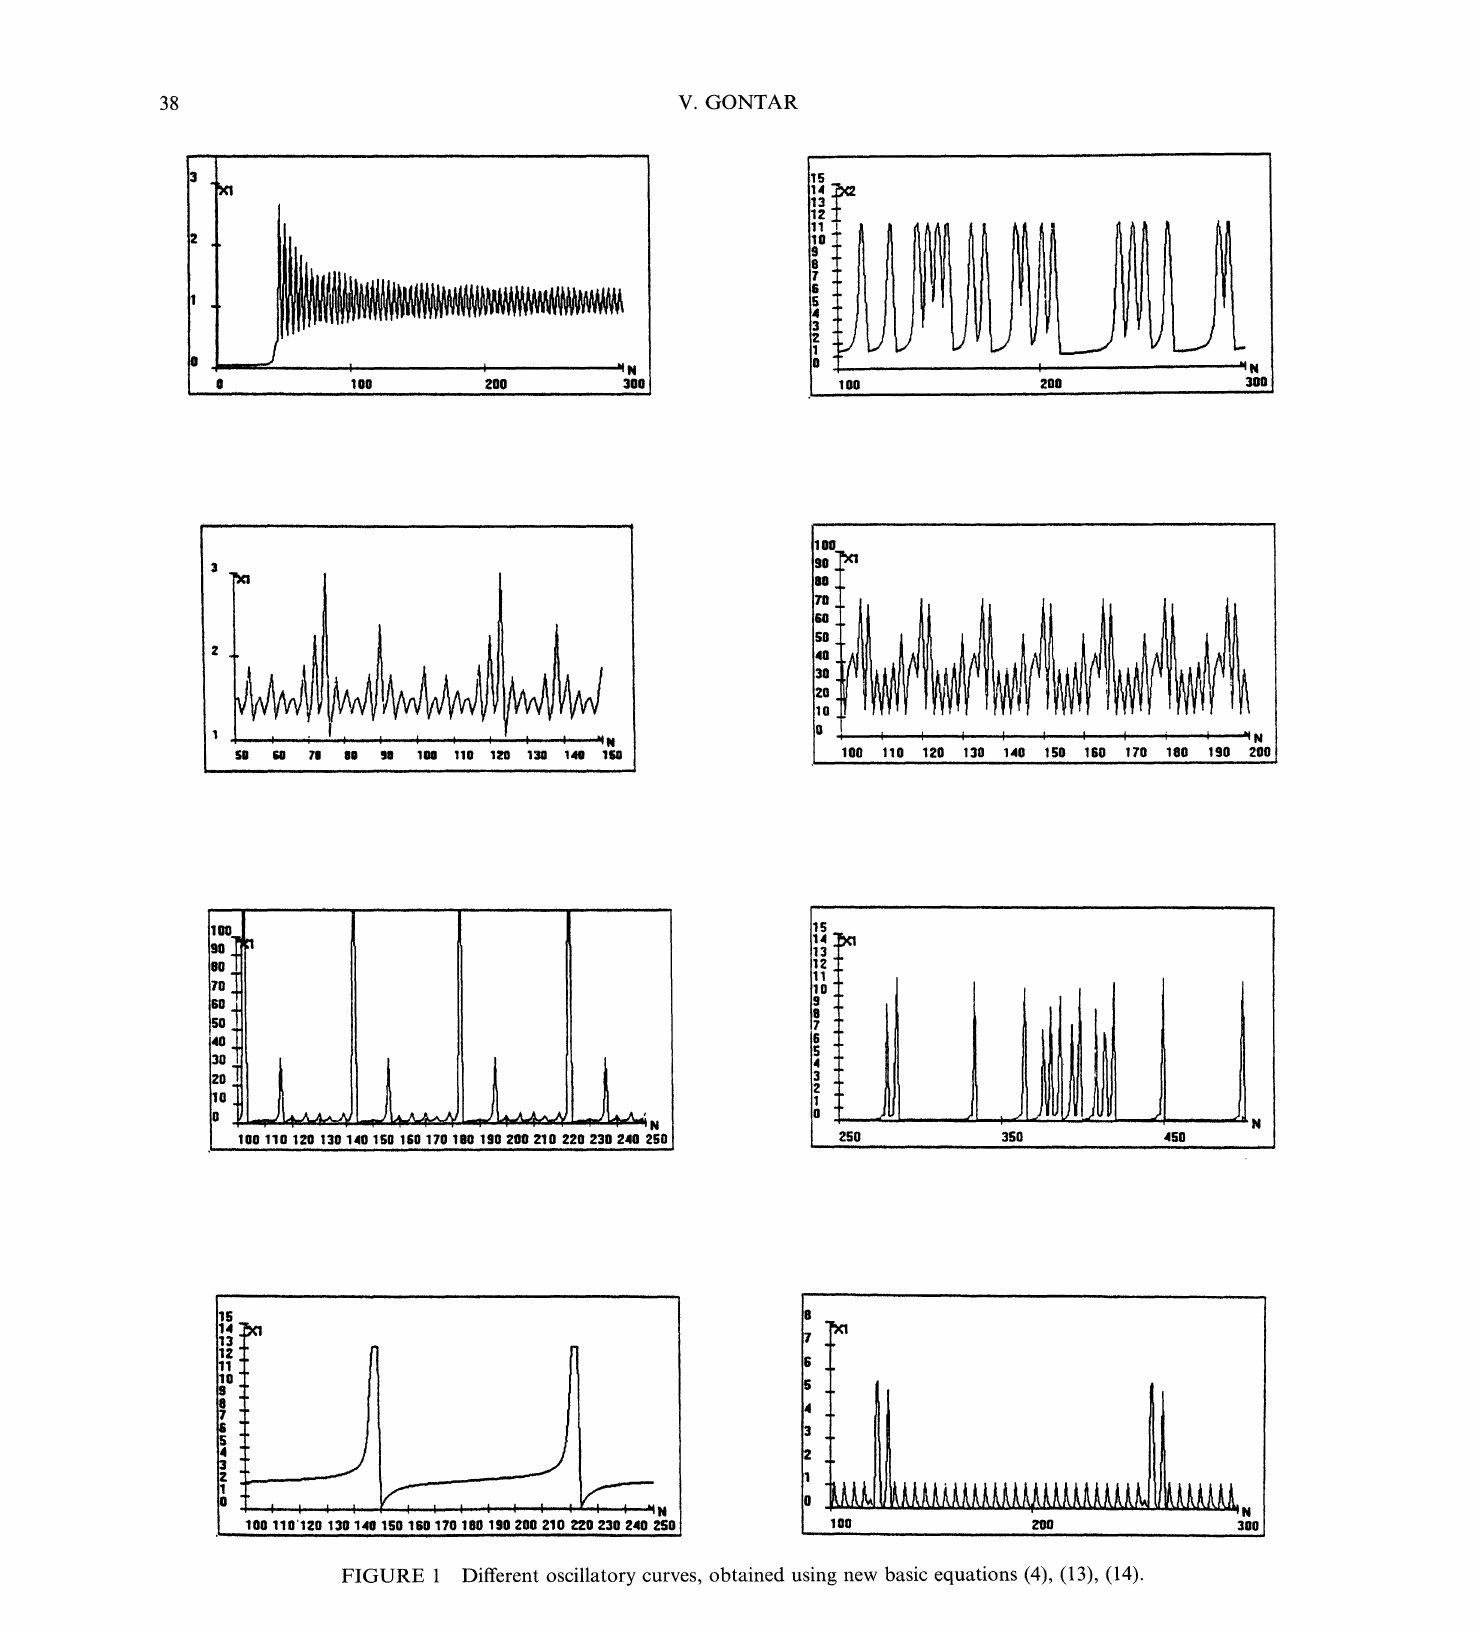
FIGURE Different oscillatory curves, obtained using new basic equations (4), (13),